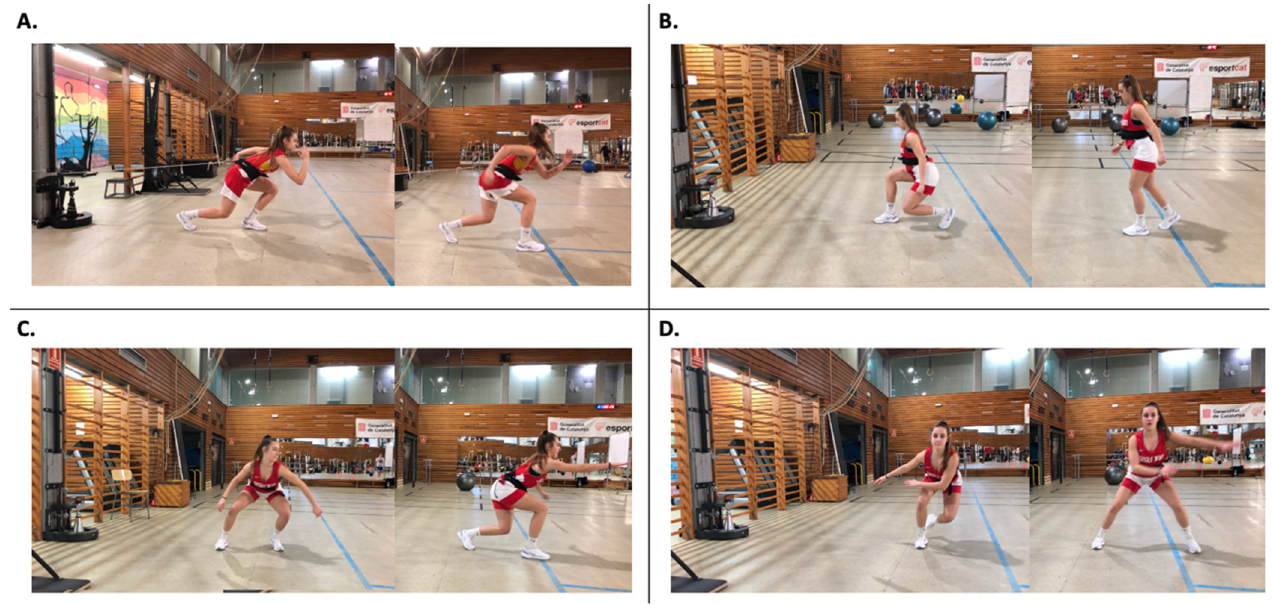
Figure 2. Testing conducted on the flywheel resistance device. ( A ) Acceleration step, ( B ) Deceleration step, ( C ) Crossover step, ( D ) Side step.